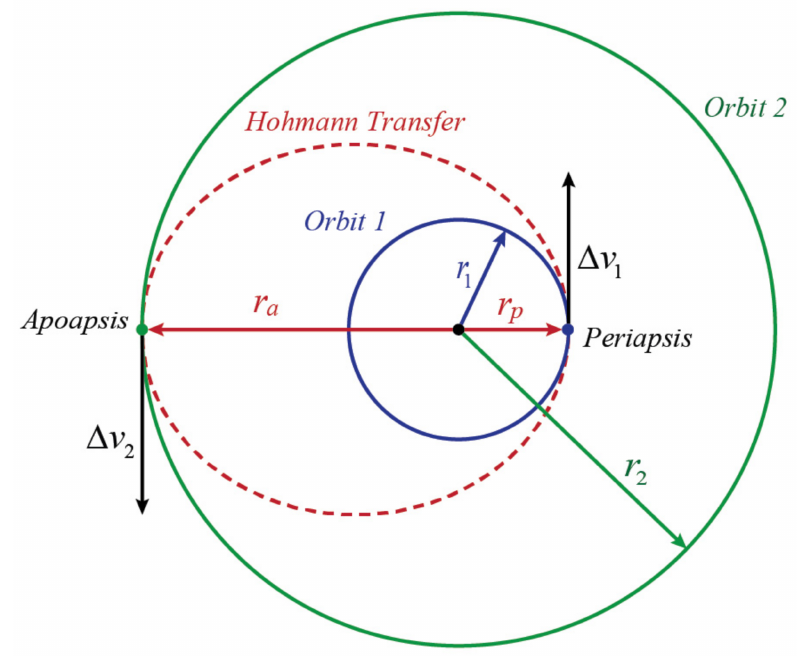
Figure 11. Hohmann Transfer